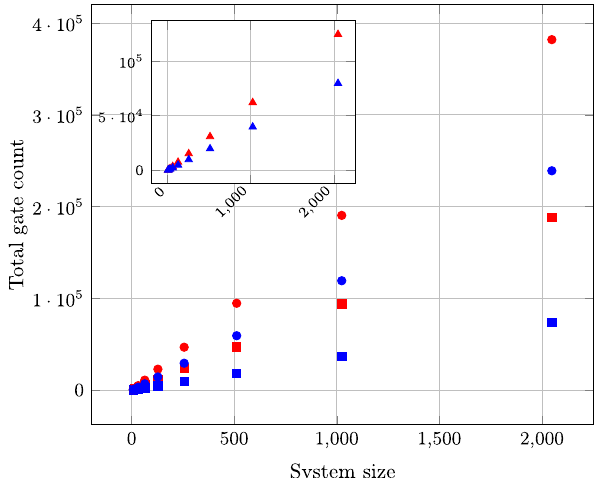
Fig. 3 Total gate count for product formula algorithms. The points in red/blue represent gate counts before/after optimization and the symbols square/circle represent gate counts for the 2nd-/4th-order formula,